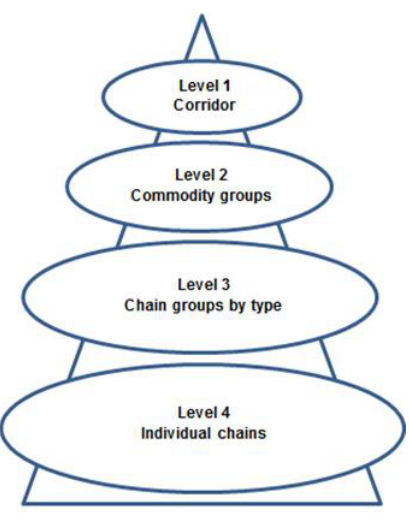
Figure 2. Sample